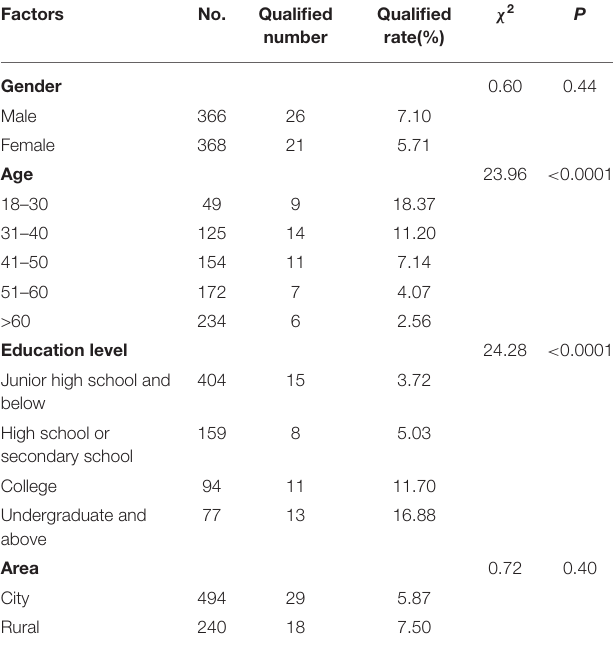
TABLE 1 | The mental health literacy of